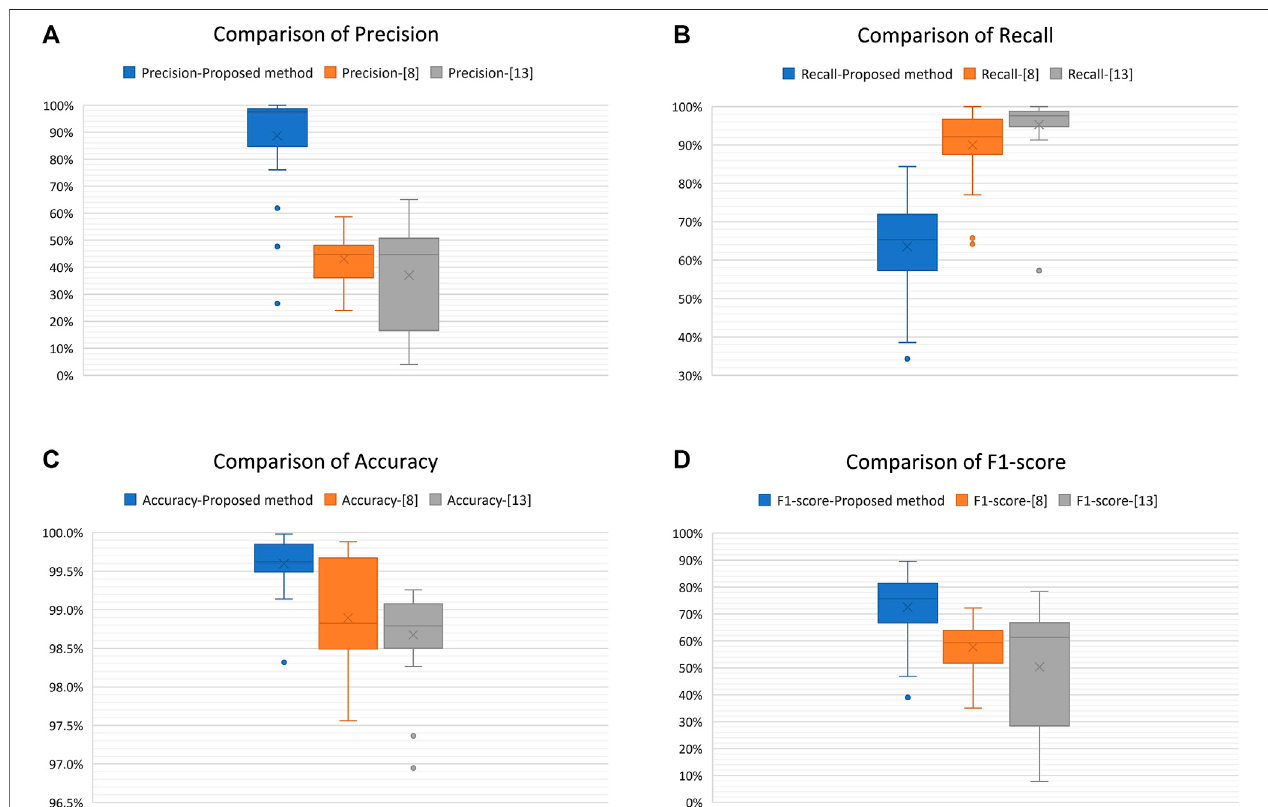
FIGURE 5 | Comparison of Precision , Recall , Accuracy , and F 1 -score , where the crosses mark averages. (A) Comparison of Precision . (B) Comparison of Recall . (C) Comparison of Accuracy . (D) Comparison of F 1 -score .